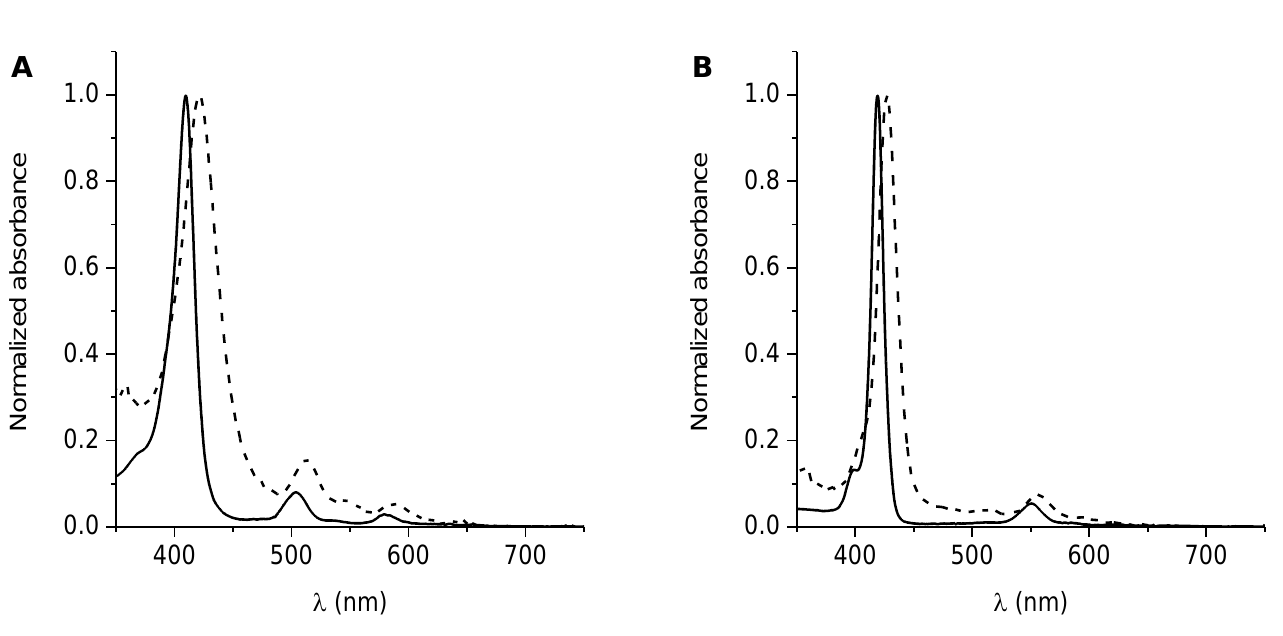
Figure 1. SEM images of ( A ) PTPPF 16 -EDA and ( B ) PZnTPPF 16 -EDA polymeric materials deposited as a film, scale bar 20 µm.